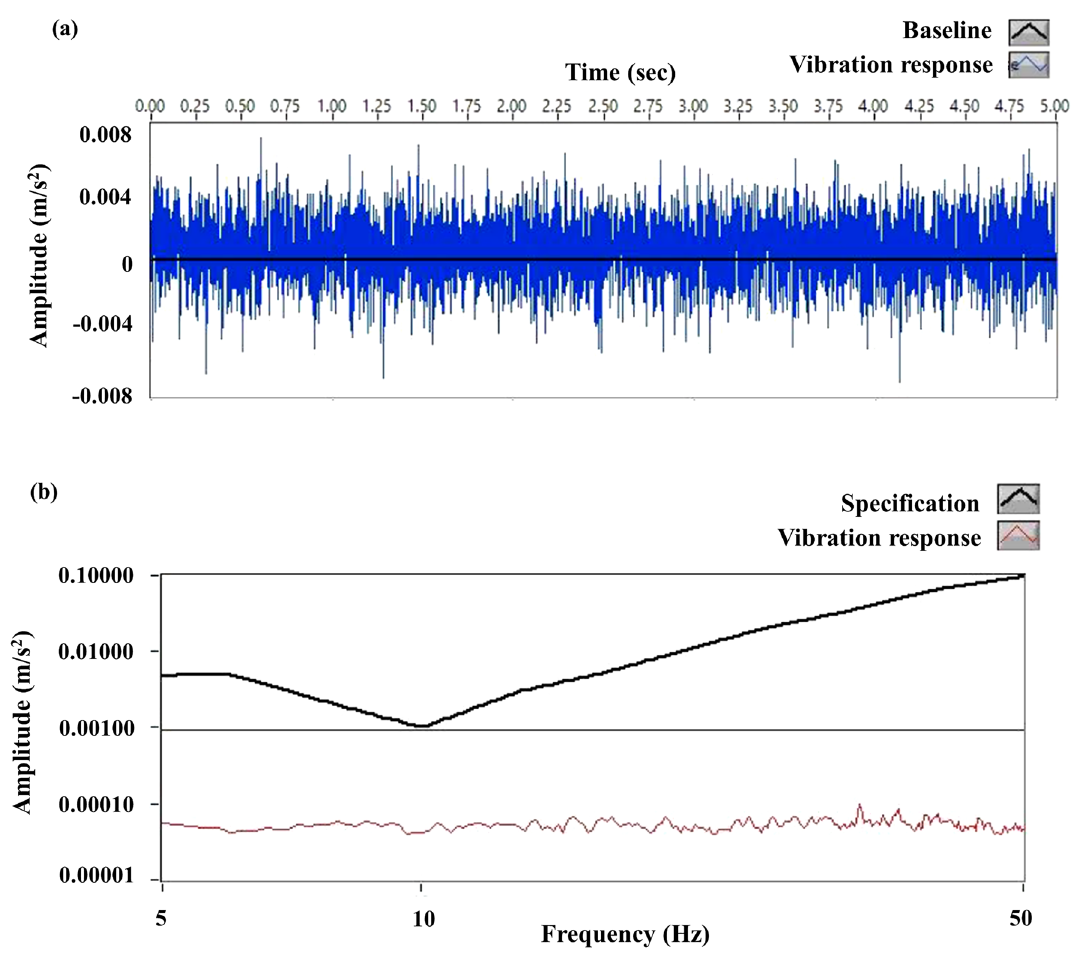
Figure 1. Magnitude of vibration according to ( a ) measurement time and ( b )